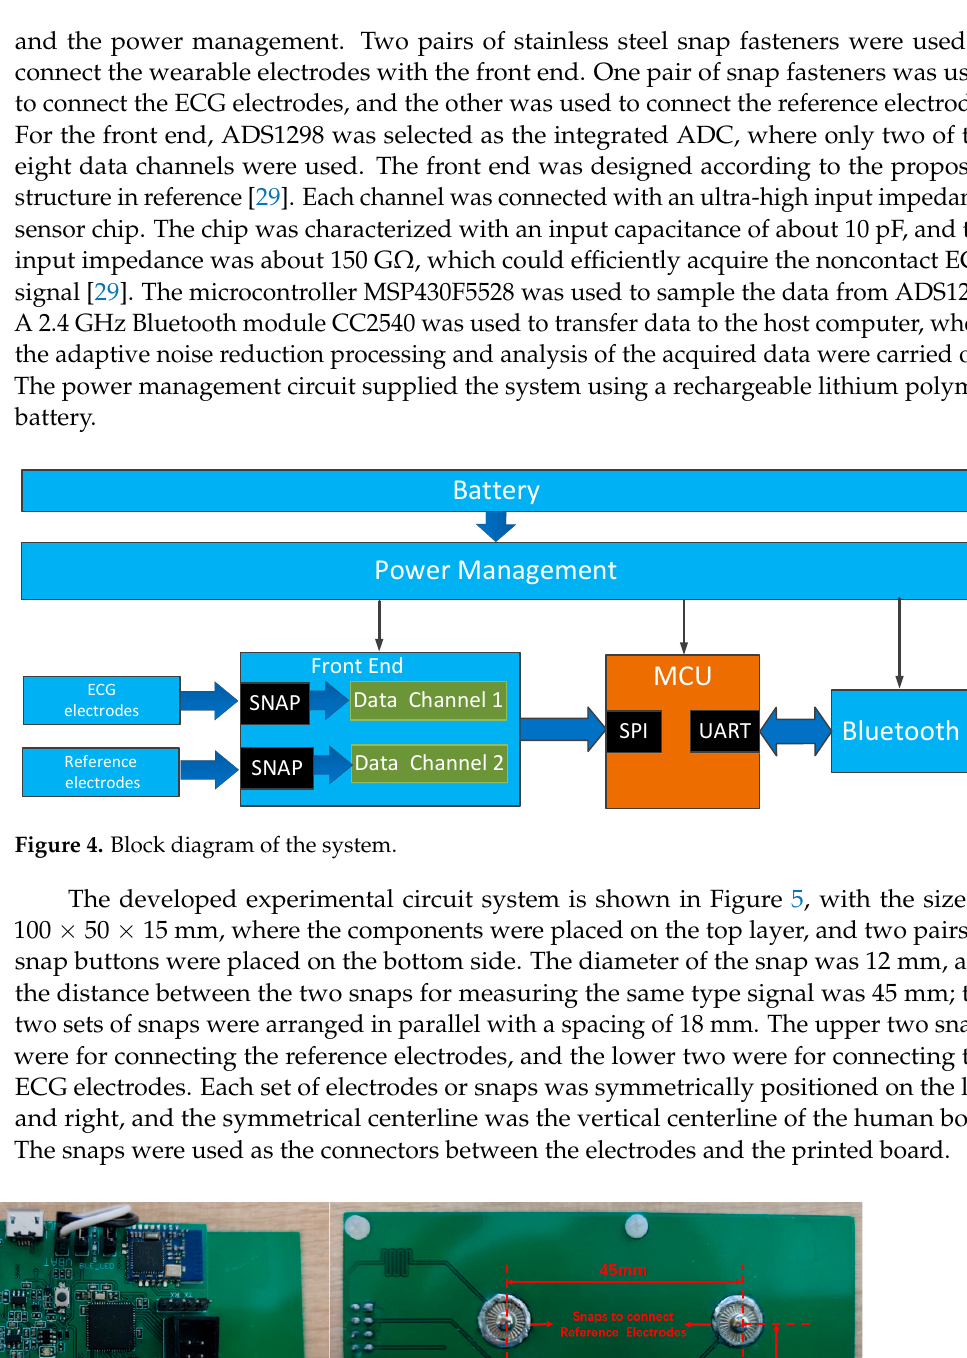
Figure 4. Block diagram of the system. Figure 5. Printed system circuit board; ( a ) top layer of the circuit board; ( b ) bottom side of the circuit board.